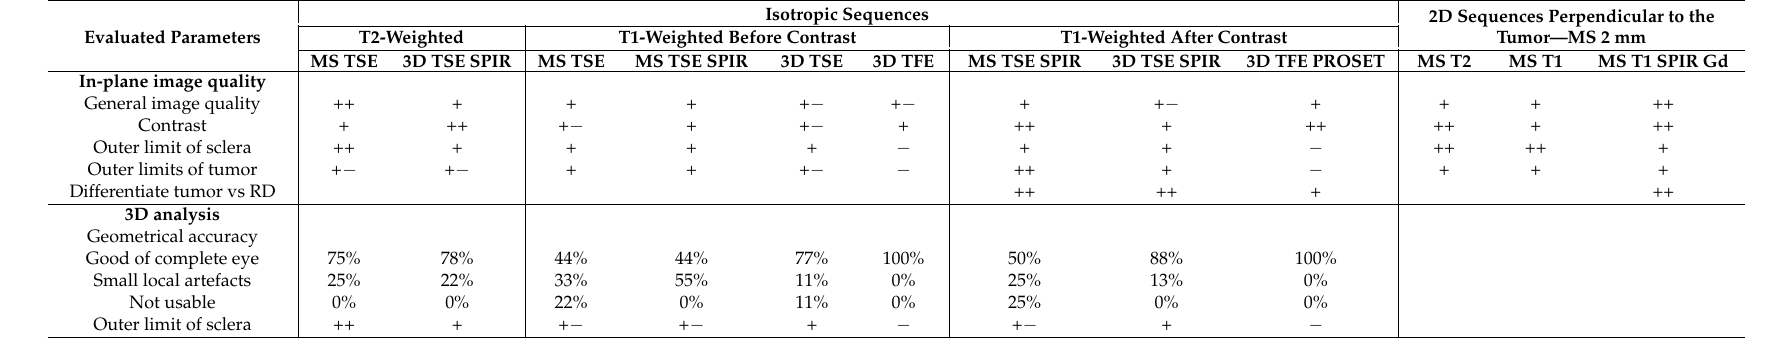
Table 3. Comparison of the anatomical sequences. ++ very good, + good, + − sufficient, − insufficient, RD—retinal